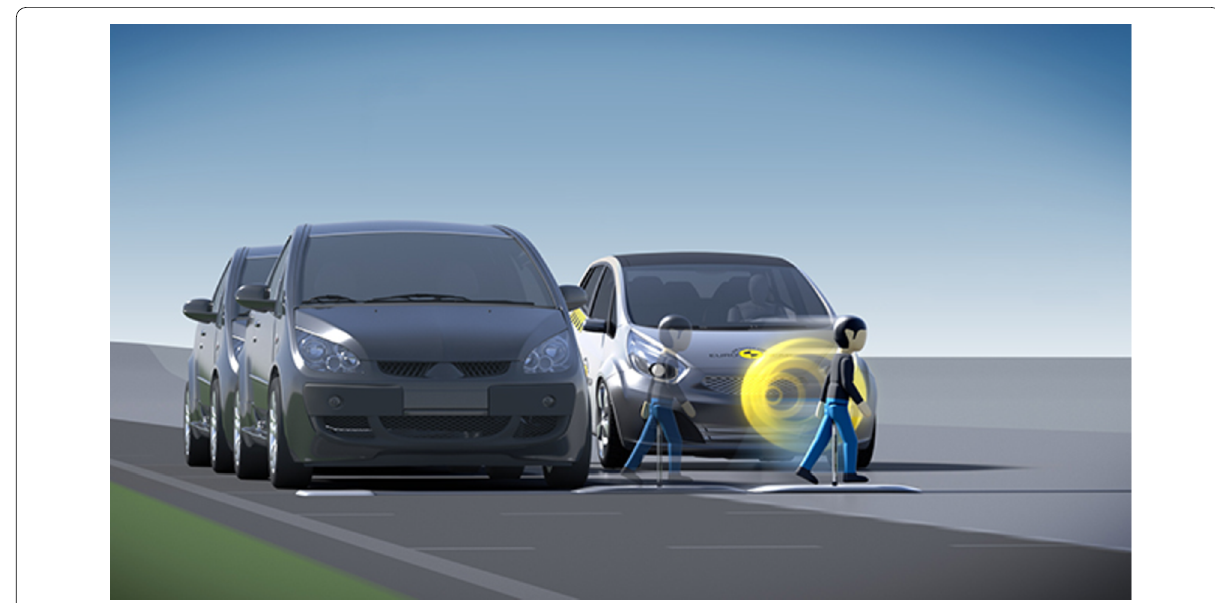
Figure 1 Test setup for pedestrian detection, where a pedestrian (child as a dummy) crosses the road behind a parked car in a scenario for testing AEB of Euro NCAP [19]